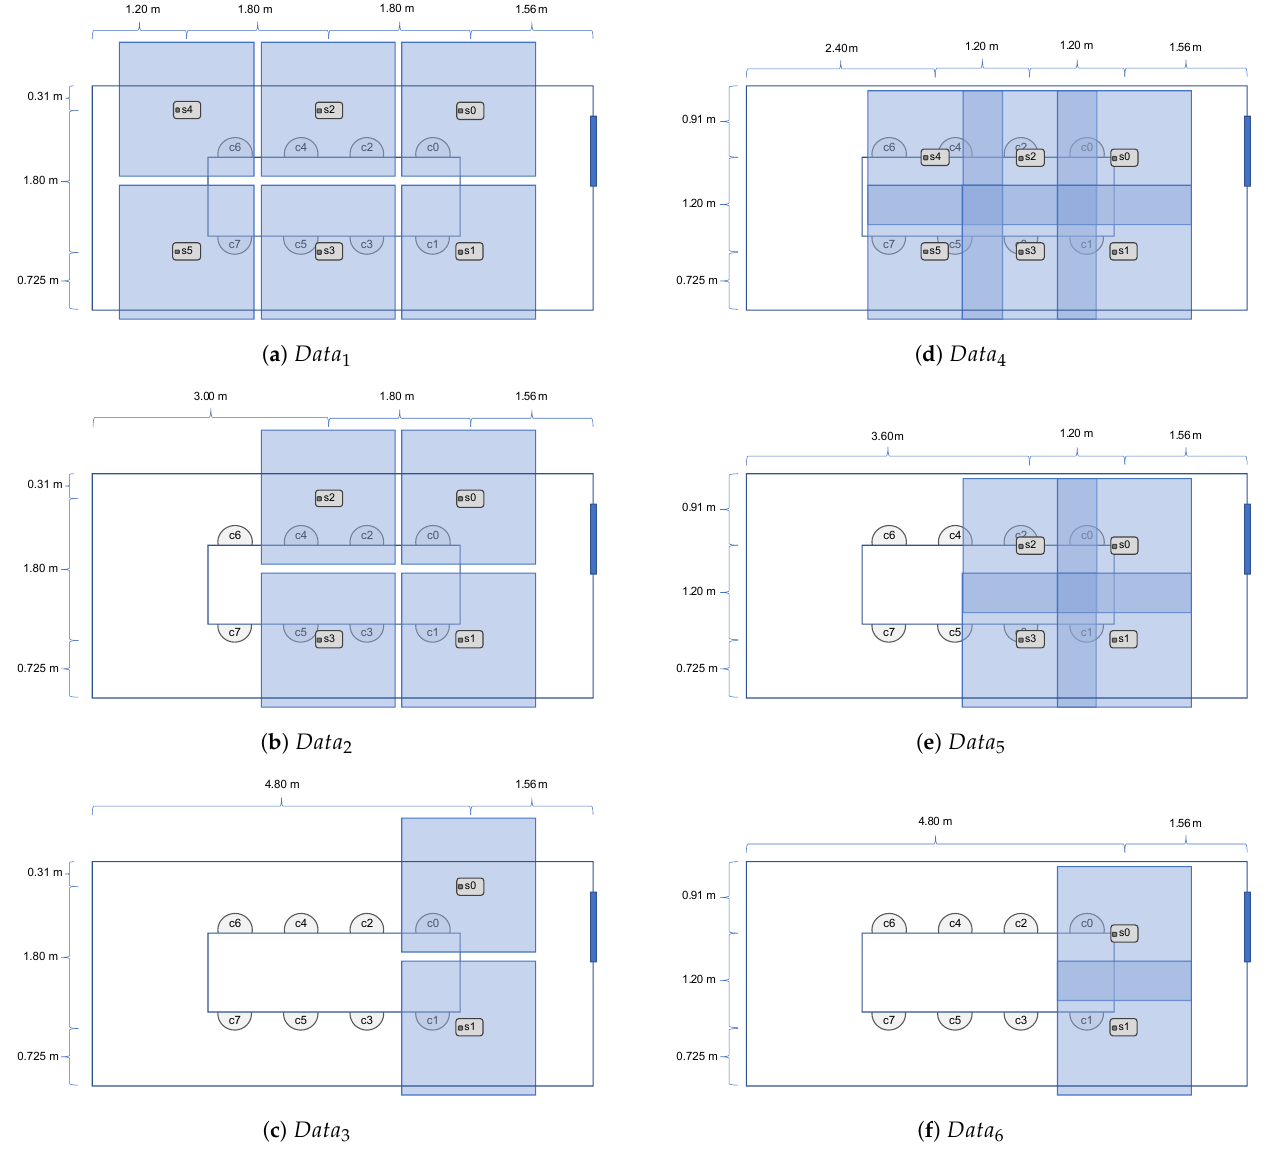
Figure 4. Data collection setups. Each sub-figure shows the setup of the sensors in each of the six different data collections; the corresponding data sets are referred to as data 1 − 6 . The sensors are shown as grey rectangles. Each sensor’s viewing area is illustrated by an opaque blue square. Subfigures ( a – c ) show sensor setup with no overlap, while subfigures ( d – f ) show sensor setup with